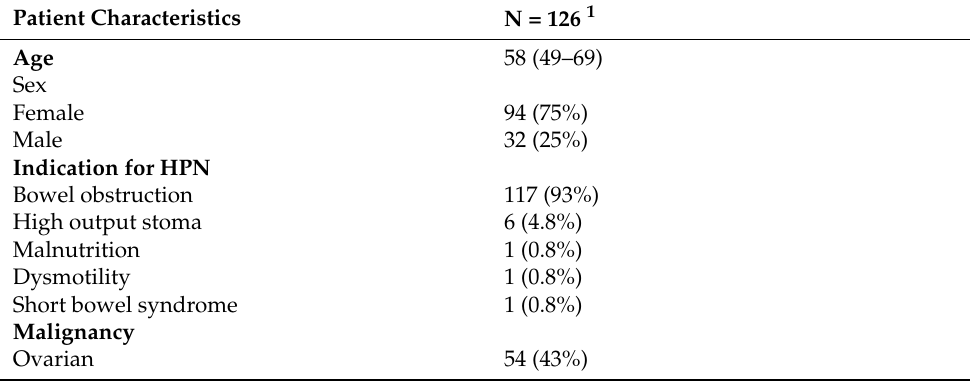
Table 1. Patient demographics and clinical